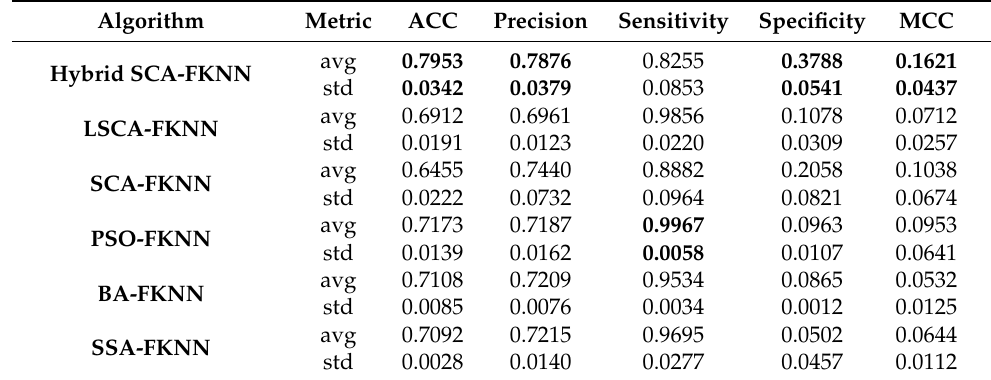
Table 9. Results of the hybrid-FKNN and comparison models on the Indian liver patient dataset (ILPD). (Bold indicates the best in comparison method).